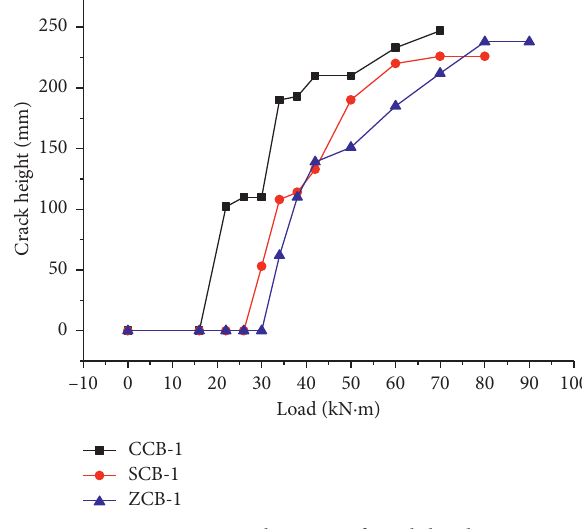
Figure 14: Development of crack height.